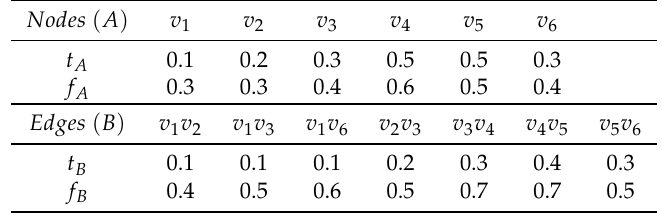
Table 2. Weights of nodes and